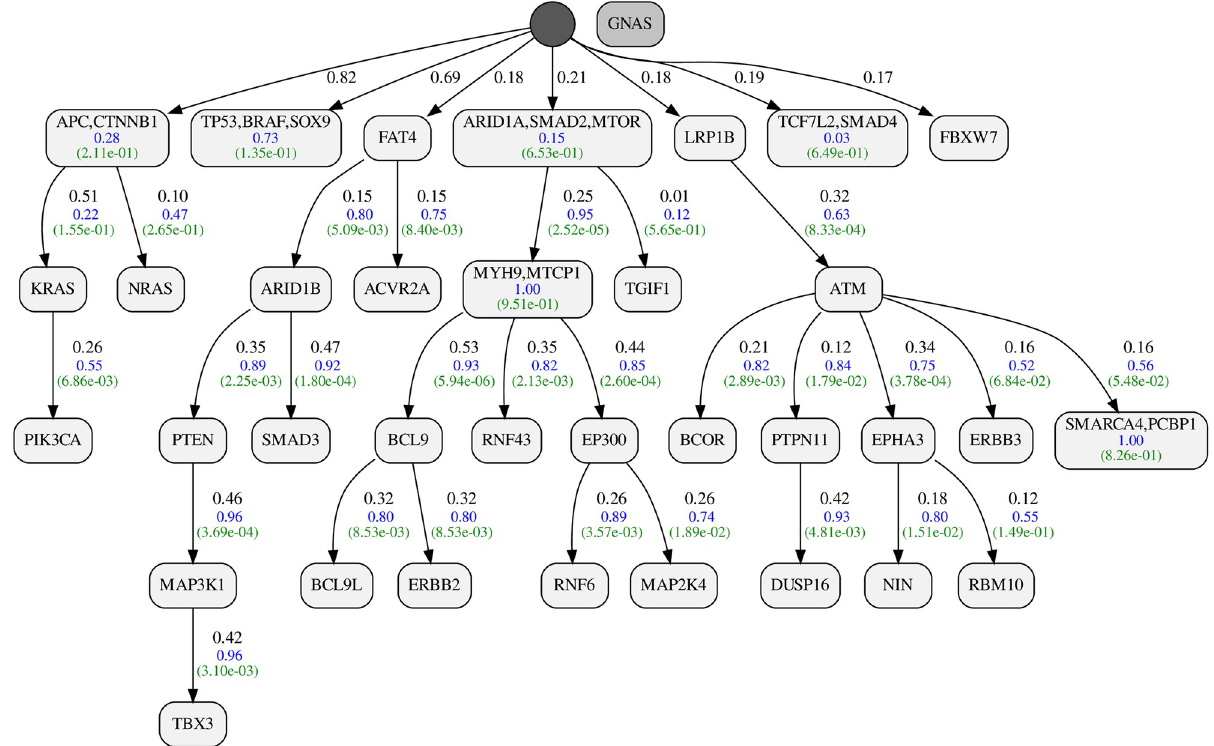
Fig 10. Inferred progression model for Colorectal Adenocarcinoma (COADREAD).